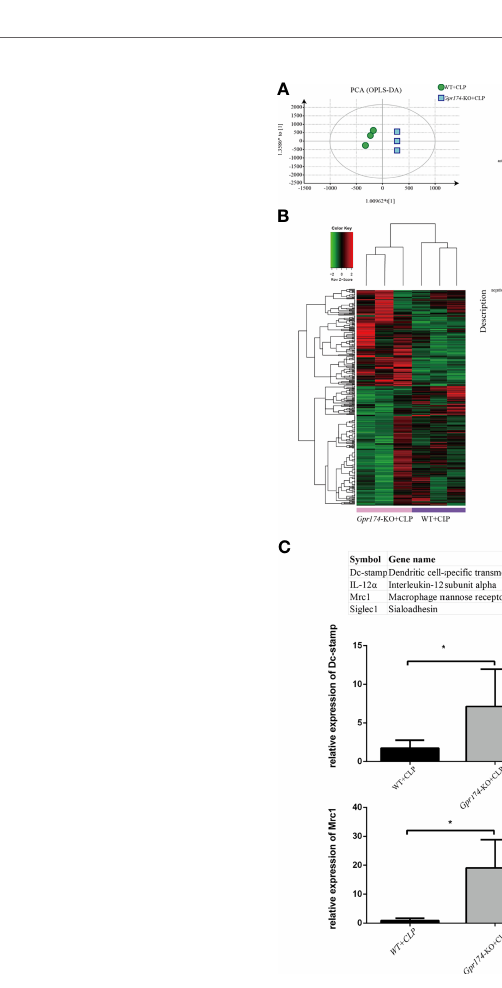
FIGURE 6 | Distinct transcriptional signature in spleen after CLP treated between Gpr174-KO and wild type mice (n = 3 per group). (A) Sample correlation was computed by PCA analysis. Percentages in PCA analysis axis indicated the proportional variance explained by PC. (B) Differentially expression genes (DEG) were expressed by heatmap with normalized raw z-scores (left) and pyramid plot with -log 10 ( P value) demonstrated the involved pathways form DES genes (right). (C) qPCR veri fi cation of most differentially expressed genes (n = 3-6). Representative genes from the table were veri fi ed by qPCR. Values are mean with SEM, *P < 0.05, **P <